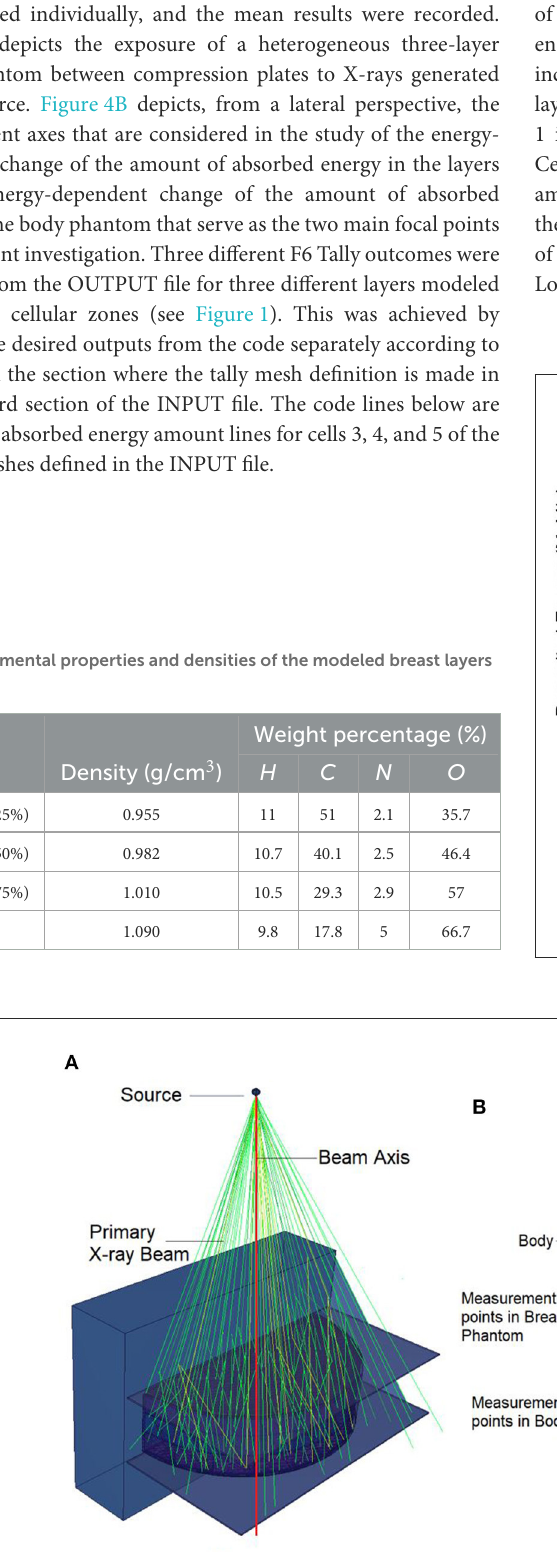
FIGURE4 (A) Appearance of X-ray source. (B) Lateral view for measurement